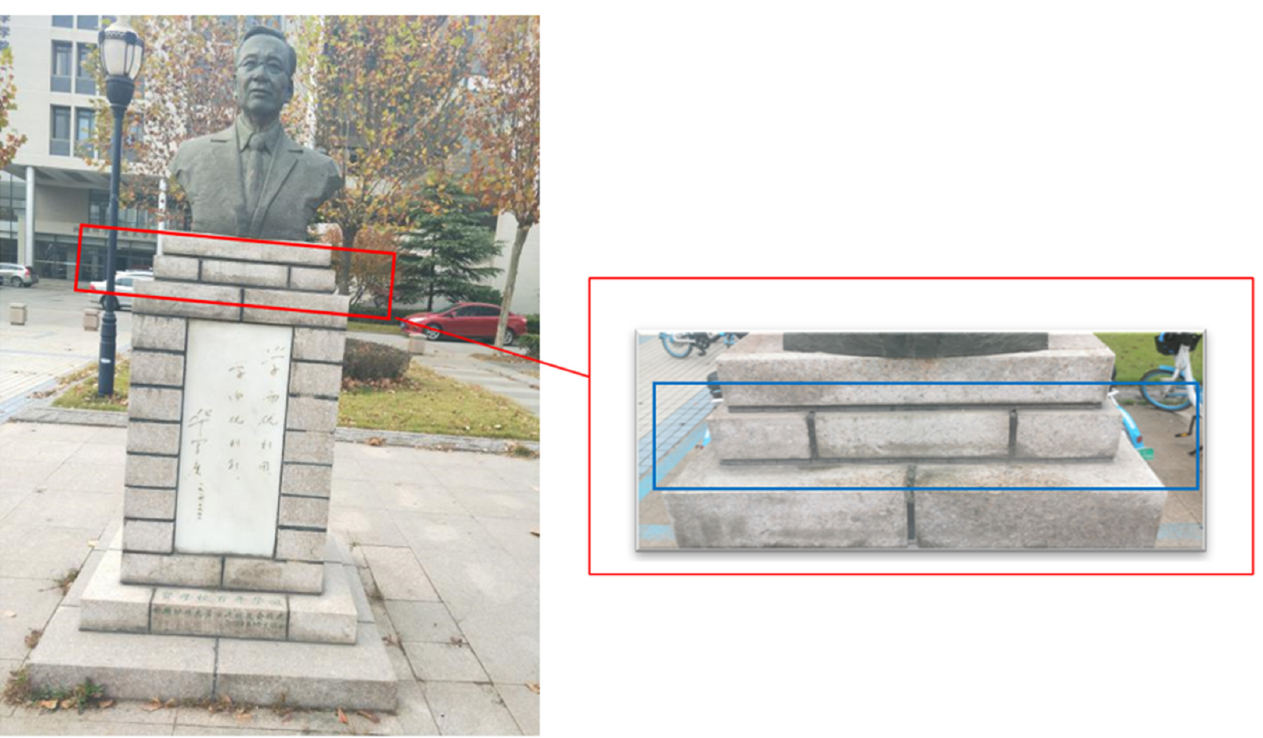
Figure 3. The real image of statue.